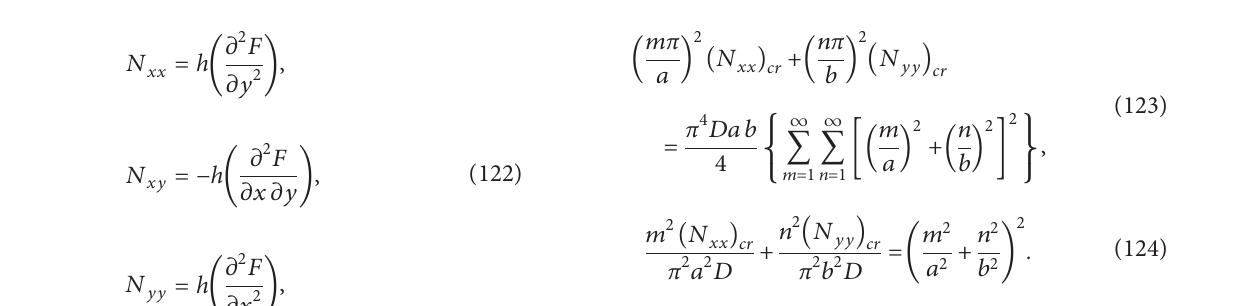
Figure 4: Comparison of membrane stiffness predictions ( K 3 ), as obtained from the current SDOF model and literature [33]. (a) Immovable edges. (b) Movable edges. (c) Stress-free